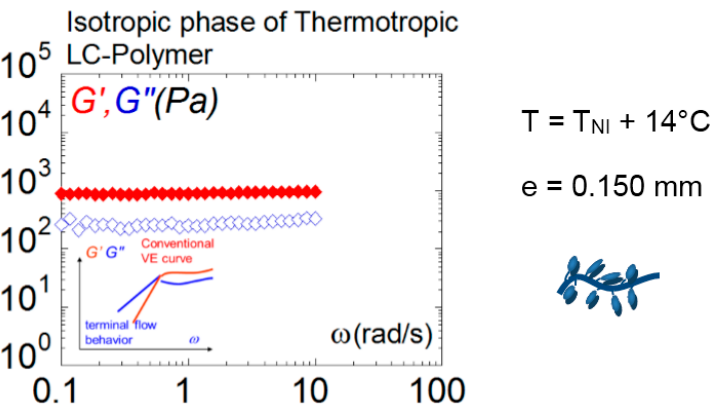
Figure 8. A strong solid-like response is measured above the isotropic–nematic transition by a liquid crystal polymer (viscoelastic moduli G’ ( ♦ ), G” ( ) recorded at 14 °C above the transition and 0.150 mm gap thickness). The lower inset displays for comparison the conventional polymer melt behavior fulfilling the Maxwell model [32]). From Mendil, Noirez, Baroni 2006 [36]). With kind permission from The European Physical Journal (EPJ).